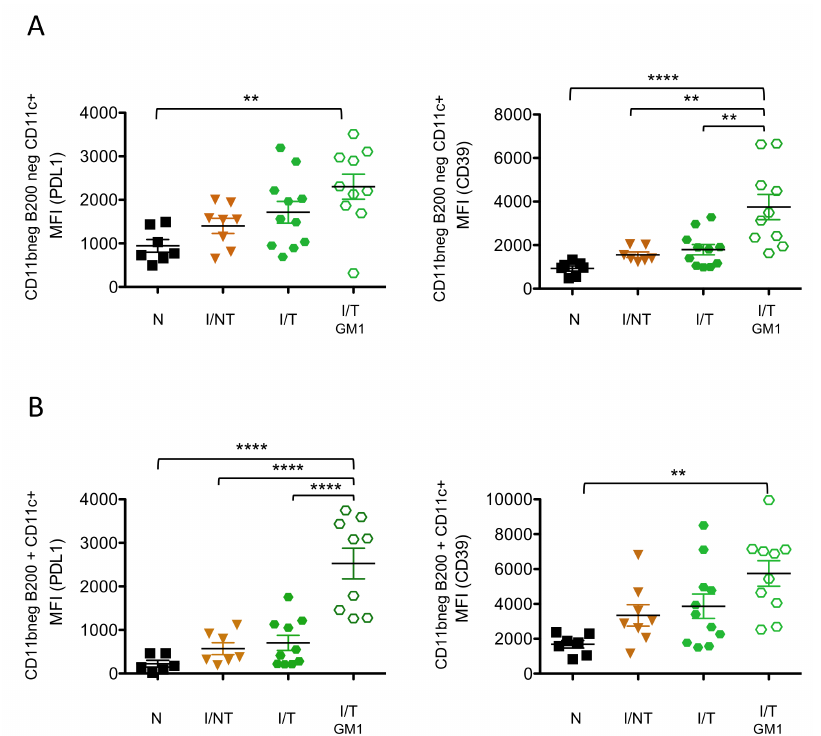
Figure 4. Effects of NK cell depletion on the expression of inhibitory receptors on DCs . NK cells in infected/treated mice were depleted, or not, as indicated in Figure 2A. Spleen cells were isolated at day 14 p.i. and flow cytometry analyzed to assess the expression levels of CD39 and PD-L1 on different subtypes of DCs: CD11c + CD11b - B220 - conventional DCs ( A ) and CD11c + CD11b - B220 + plasmacytoid DCs (pDCs) ( B ). The data correspond to 3 independent experiments with the following number of mice per group: naïve (N) ( n = 7); infected/non-treated (I/NT) ( n = 8);